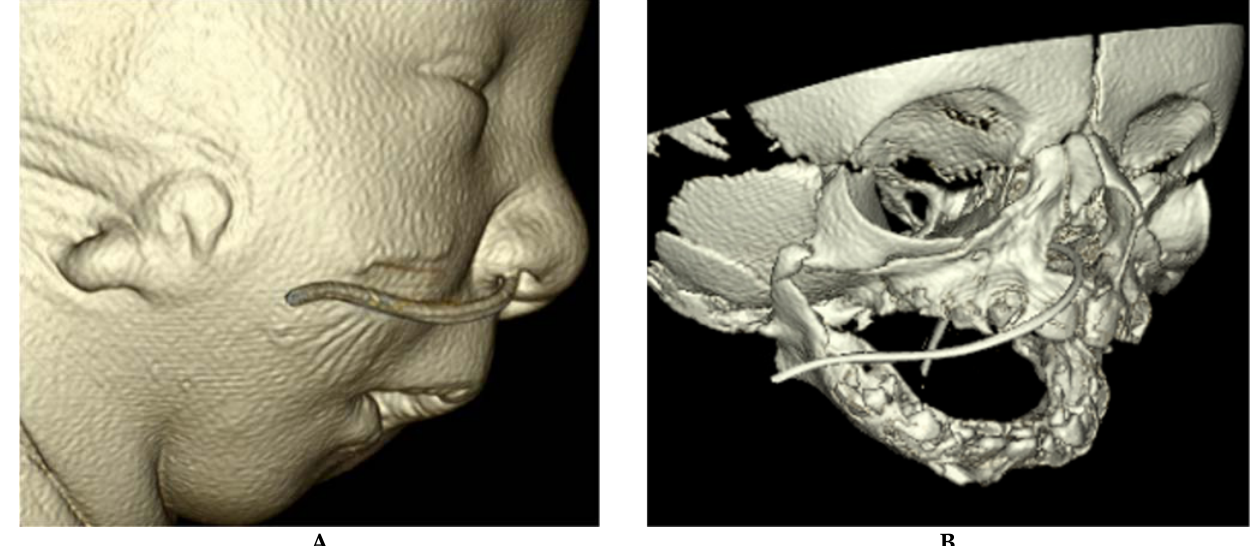
Figure 6. ( A ) CT reconstruction images of a patient with Treacher Collins syndrome. ( B ) CT recon- struction image of a patient with Treacher Collins syndrome. Note the maxillary and mandibular hypoplasia and micrognathia. This patient had bilateral microtia.